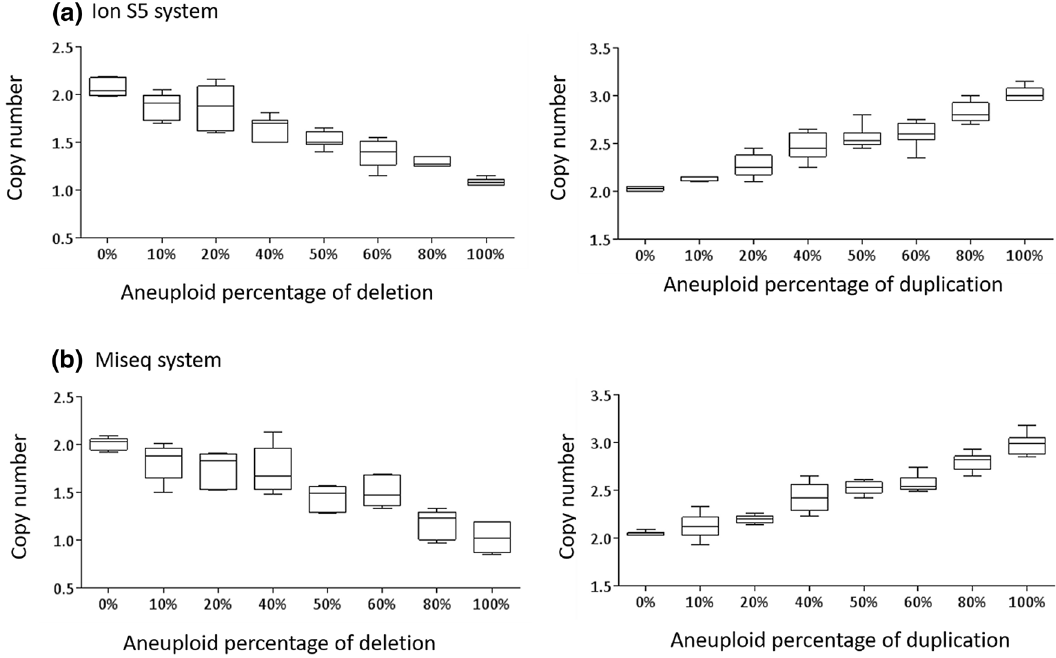
Figure 1. Cell lines are mixed to create multiple levels of aneuploidy. The calculated copy number at the affected aneuploid region displayed correlation with the aneuploid percentage using automatic identification via the Ion Reporter on the Ion S5 system ( 1a ), and using manual identification via the BlueFuse Multi on the Miseq system ( 1b ). As the number of aneuploid cells in the mixtures increases, the copy number of the regions with segmental deletion or whole-chromosome duplication decreases or increases on both the NGS